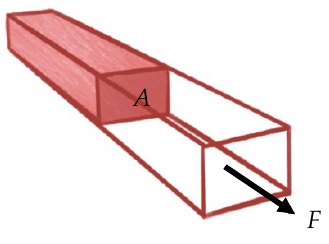
Figure 4. Stress illustrated.